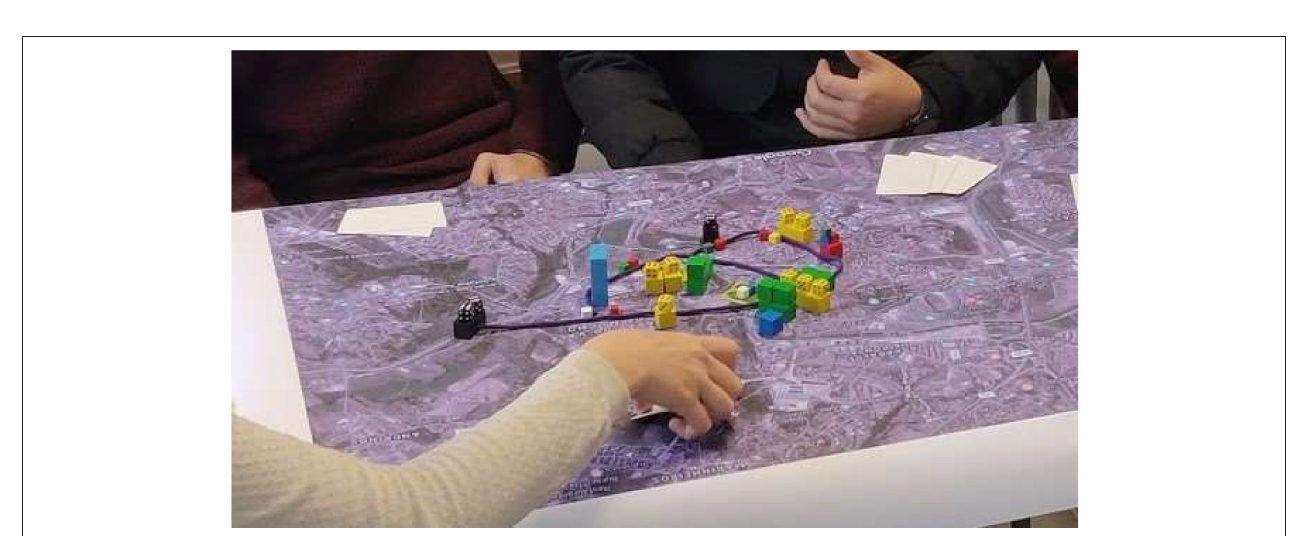
FIGURE 3 | Game play of the second